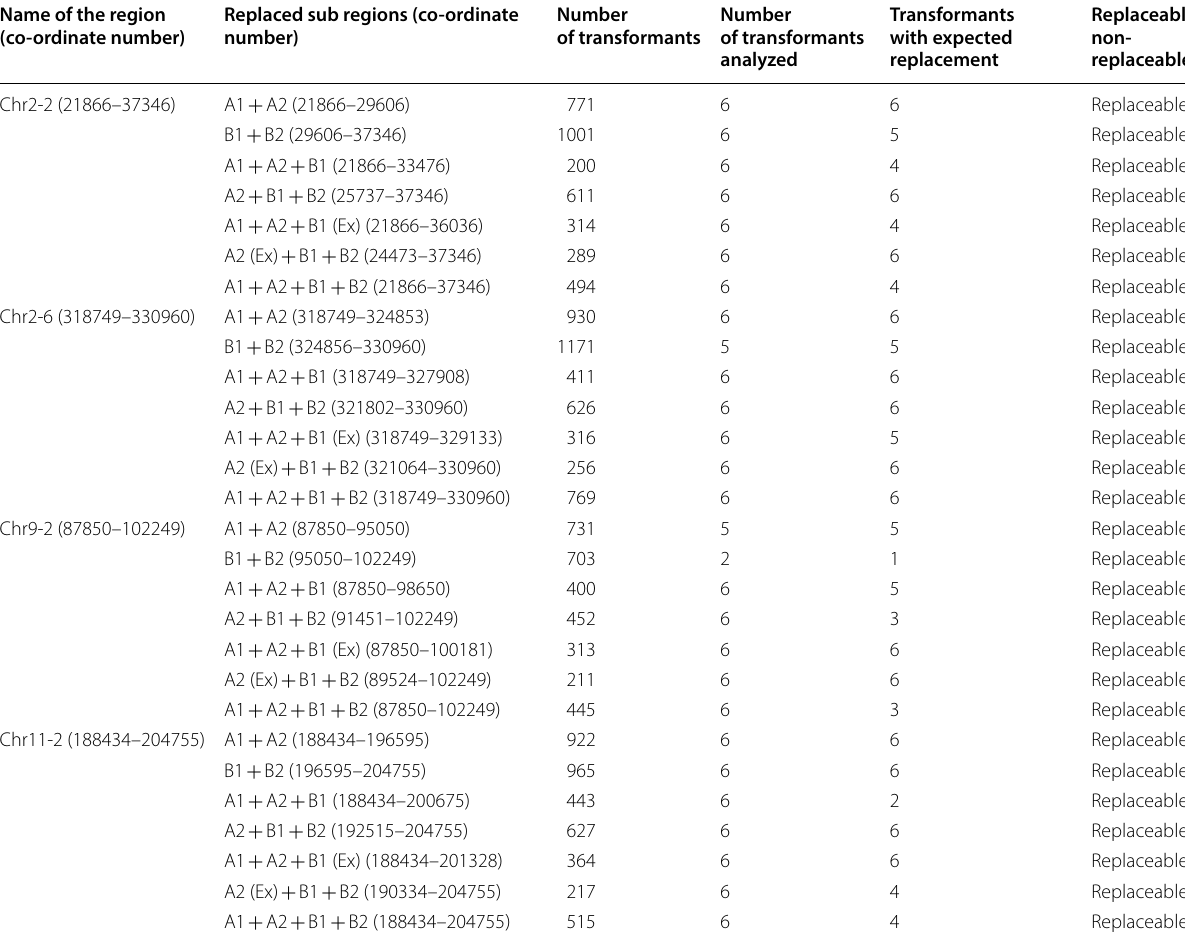
Table 2 Replacement of various chromosomal regions Name of the region (co‑ordinate number)